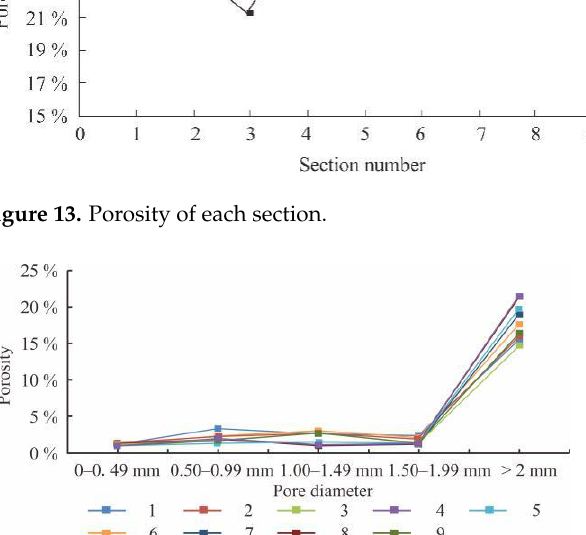
Figure 14. Pore size ratio of each section.